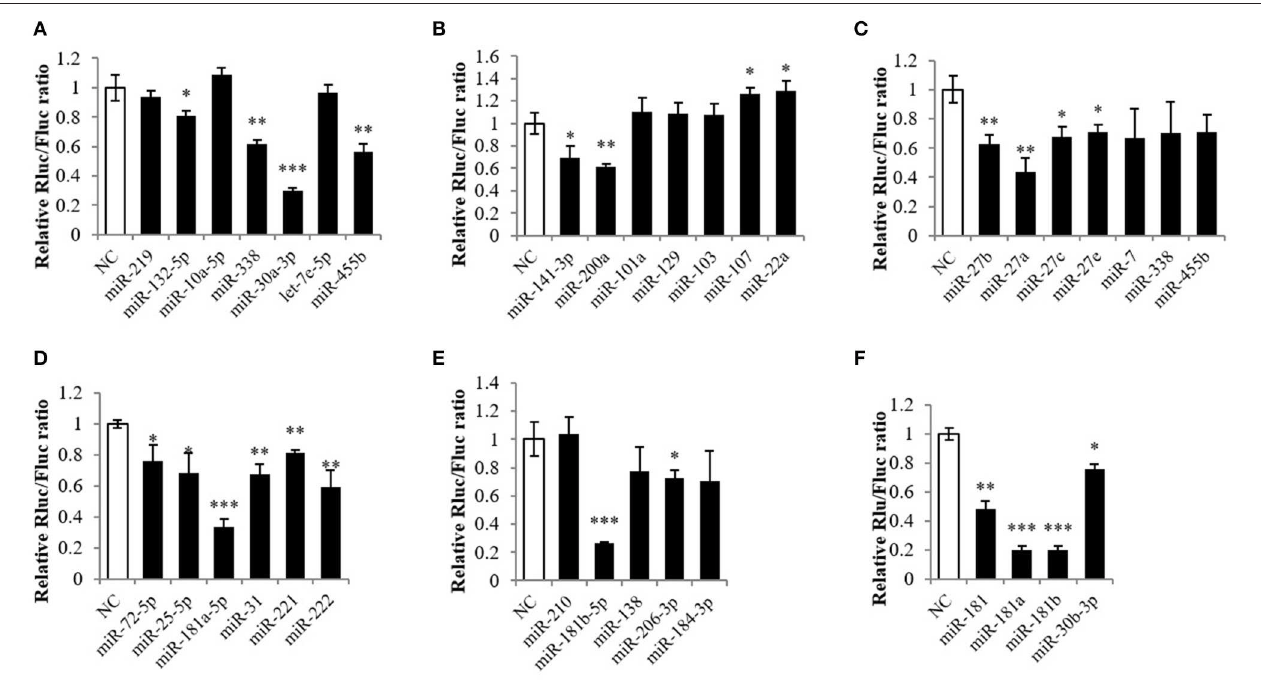
FIGURE 2 | Screening the targeting miRNA of Mstnb . Dual luciferase assay with psiCHECK2- Mstnb and predicted target miRNA, and the y-axis is represented by the ratio of ranilla luciferase to firefly luciferase. (A–F) Showed different miRNA may target mstnb. (A) miR-338, miR-30a-3p, and miR-455b; (B) miR-141-3p and miR-200a; (C) miR-27b, miR-27a, and miR-27c; (D) miR-181a-5p, miR-31, miR-221, and miR- 222; (E) miR-181b-5p and miR-206-3p; (F) miR-181, miR-181a/b, and miR-30b-3p. Bar: mean ± SEM. * P < 0.05, ** P < 0.01, and *** P < 0.001 One-way ANOVA analysis, n =